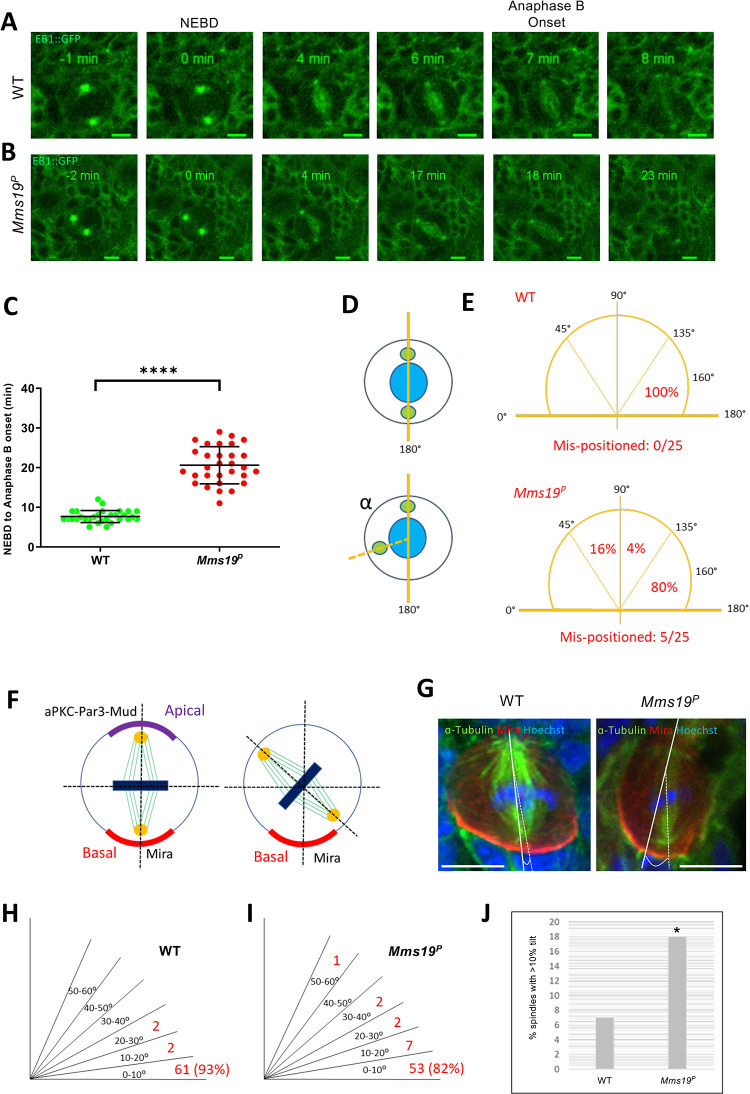
NBs depend on Mms19 for timely and coordinated spindle assembly and orientation.(A-C) WT NBs typically start anaphase B 6–7 min after the onset of NEBD. (B) Mms19P NBs require on average 15–20 min to reach anaphase B onset. (B-C) n = 30 NBs per genotype, 1 experiment. The quantitative assessment of the duration of WT and Mms19P mitoses is compared in (C). SS was determined by an unpaired t-test (***P<0.001); Scale = 5μm. In this particular Mms19P NB (B) the spindle poles are not fully separated at NEBD and the spindle initially appears kinked. (D) To analyze centrosome positioning defects, we measured the angle between the two centrosomes relative to the center of the nucleus, just before NEBD. (E) In most WT NBs, the angle between the centrosomes fell between 135° and 180°. However, 20% of the mutant NBs displayed centrosome separation defects as the angle was lower than 135°. N = 25 per genotype, 1 experiment. Additionally, in some of the Mms19P NBs analyzed, the spindles changed their orientation throughout the course of mitosis, indicating spindle orientation defects. (F) Spindle orientation in the WT NBs is tightly coupled to the apical-basal polarity axis and this is reflected by the angle formed by the spindle with respect to the basal Mira crescent. (G) In a fraction of Mms19P NBs the spindle appears misoriented with respect to (w.r.t) the Mira crescent localization. (H-J) Quantification of the spindle angle revealed that a considerably higher number of Mms19P NBs are oriented at an angle of more than 10° w.r.t Mira. Significance was calculated using Fisher’s exact test, *(P = 0.0309). n = 65 NBs per genotype, 3 experiments, scale = 5μm.